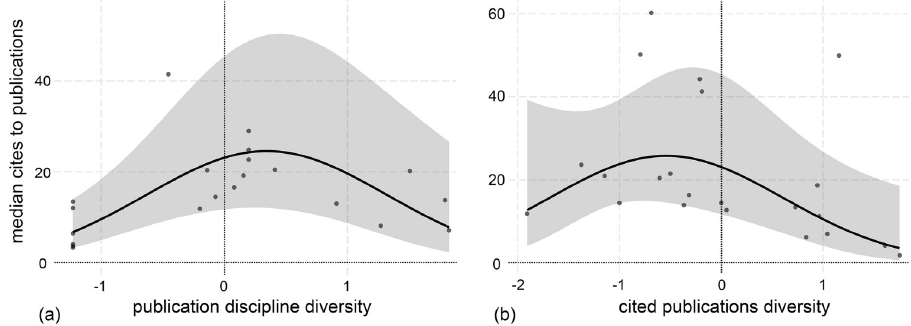
Fig 3. Influences on citations received. The median number of citations received by a group’s publications against (a) publication discipline and (b) the diversity of publications cited. One group is an outlier to the plot in 4(a) and is not visible in the plot. The 95% confidence envelope around the trend is shown. ‘0’ on the axes is the grand mean for all groups for that variable, and the intervals shown are one standard deviation from the mean. The data points show the partial residuals for the groups, i.e., the residual after controlling for the other variables in the